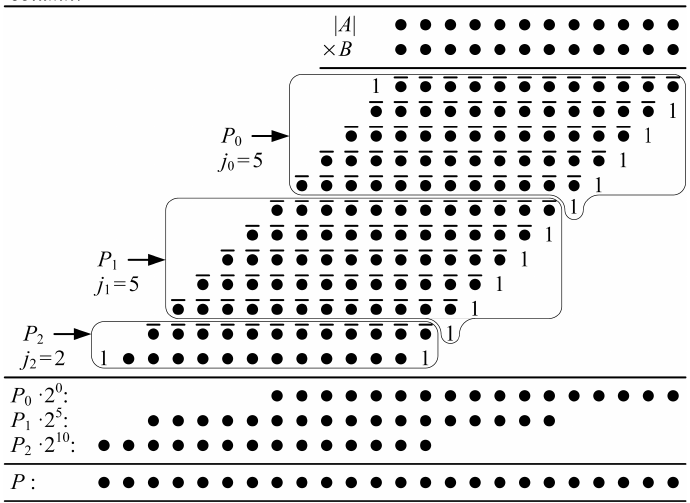
Figure 5. Proposed ( m × n )-bit KCM, where m = n = 12, A is a negative constant and B is a signed variable. When A is positive, the pre-computed values are different but the grouping of partial products and required resources are the